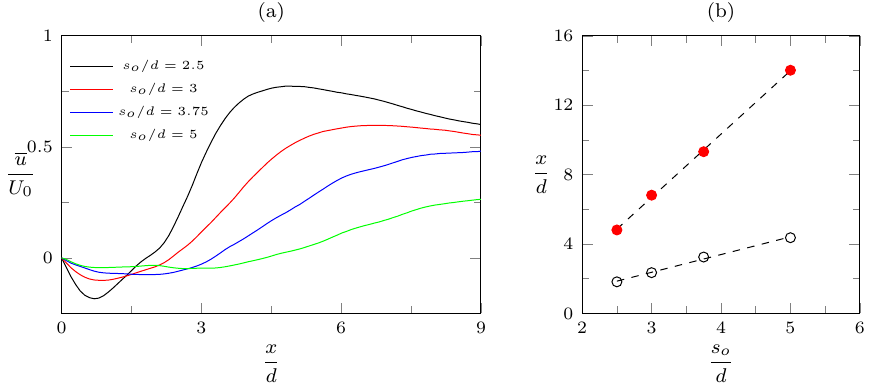
Figure 15. ( a ) Streamwise distribution of the time-averaged streamwise velocity ¯ u along the x axis; ( b ) Streamwise location of merging ( with linear fits (dashed